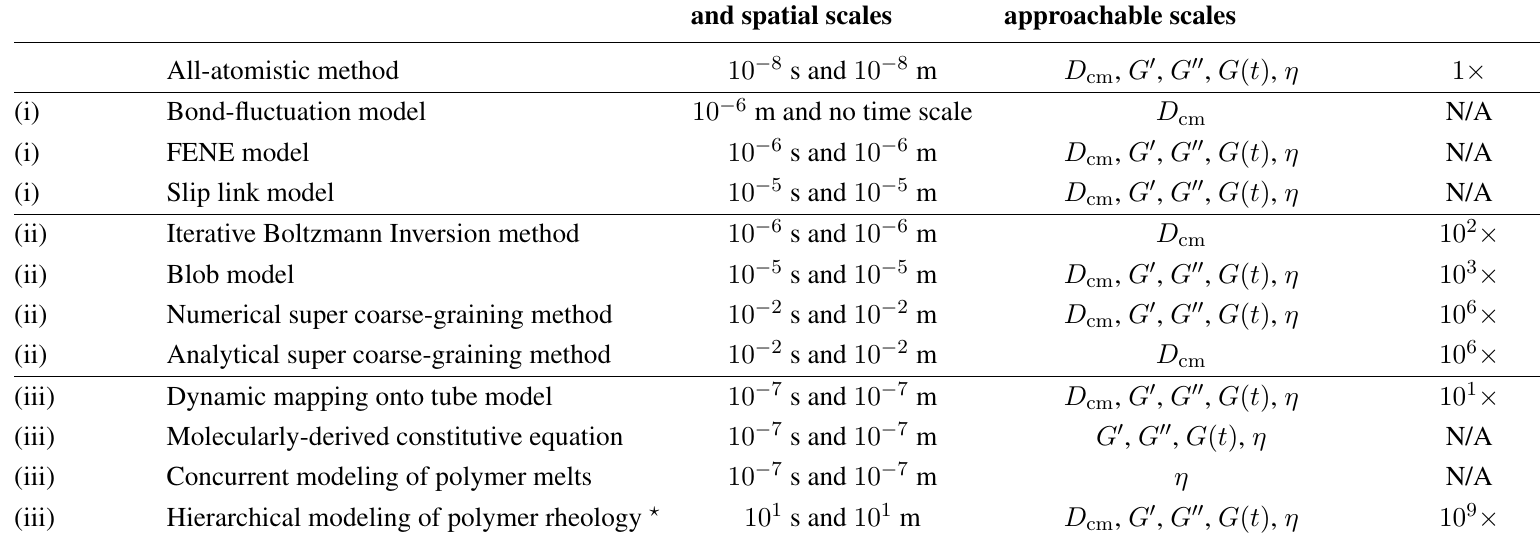
Table 2. Comparison of the methods discussed in this review. D is the self-diffusion coefficient. G (cid:48) and G (cid:48)(cid:48) are the storage and loss cm moduli, respectively. G ( t ) and η denote the shear relaxation modulus and viscosity, respectively. The approachable temporal and spatial scales vary with the computer platform and the number of processors used. The acceleration of different multiscale modeling methods is estimated by taking the all-atomistic method as a baseline. Note that the bond-fluctuation method, FENE model and slip link model